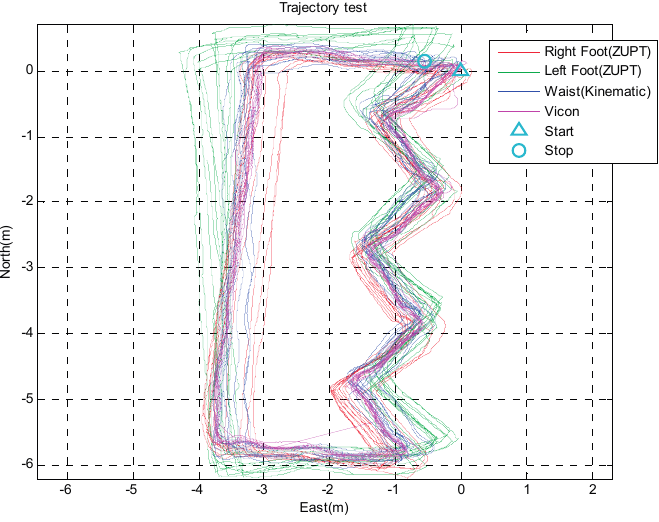
Figure 13. Experimental setting to compare the results of the proposed algorithm with the Vicon setup.